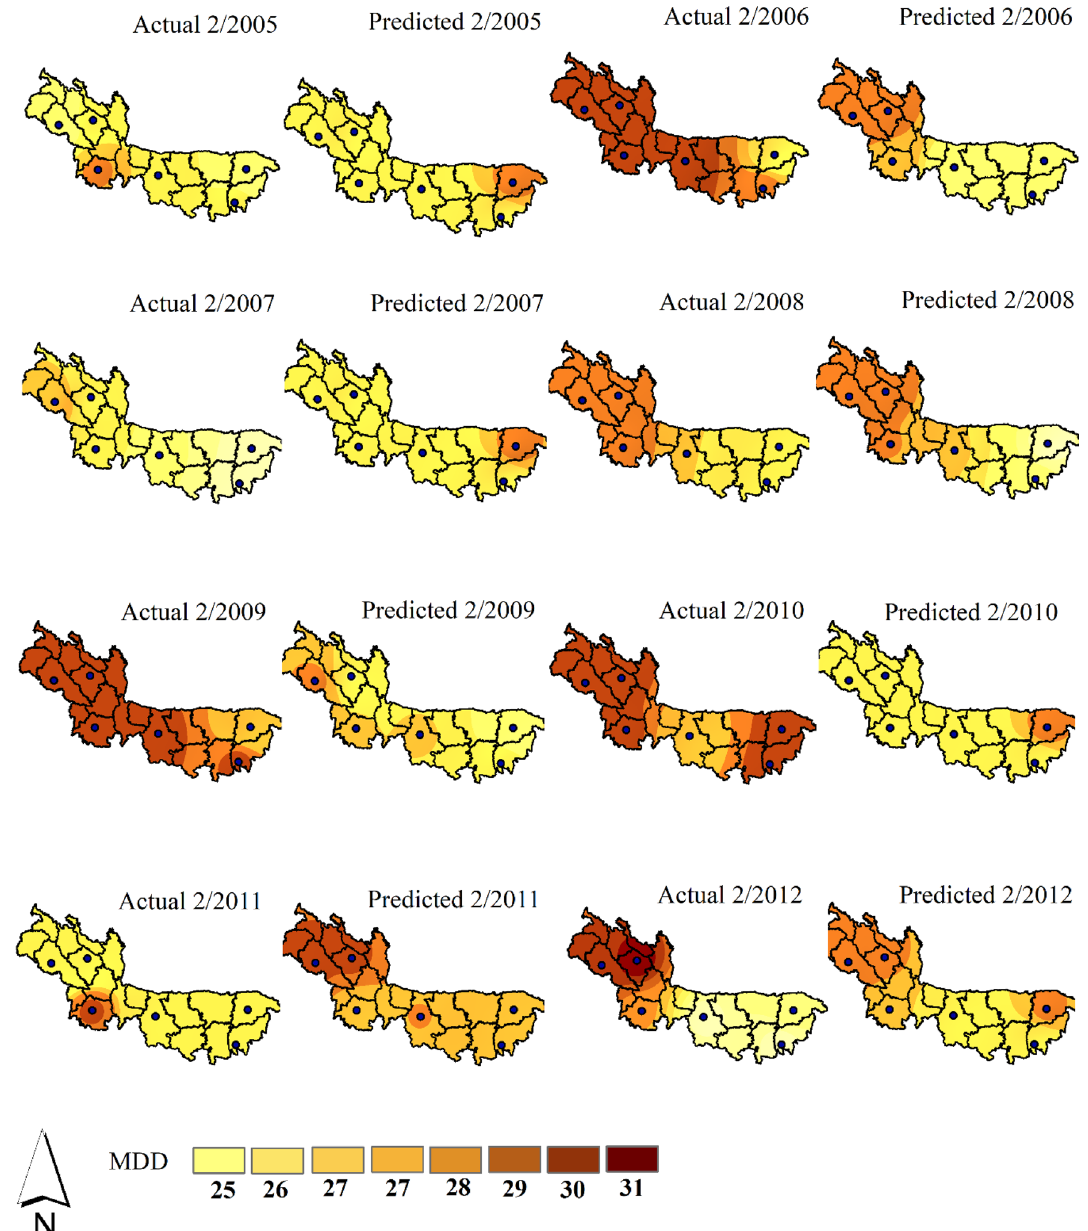
Figure 3. Spatiotemporal distribution of actual and predicted MDD using EGPR at all